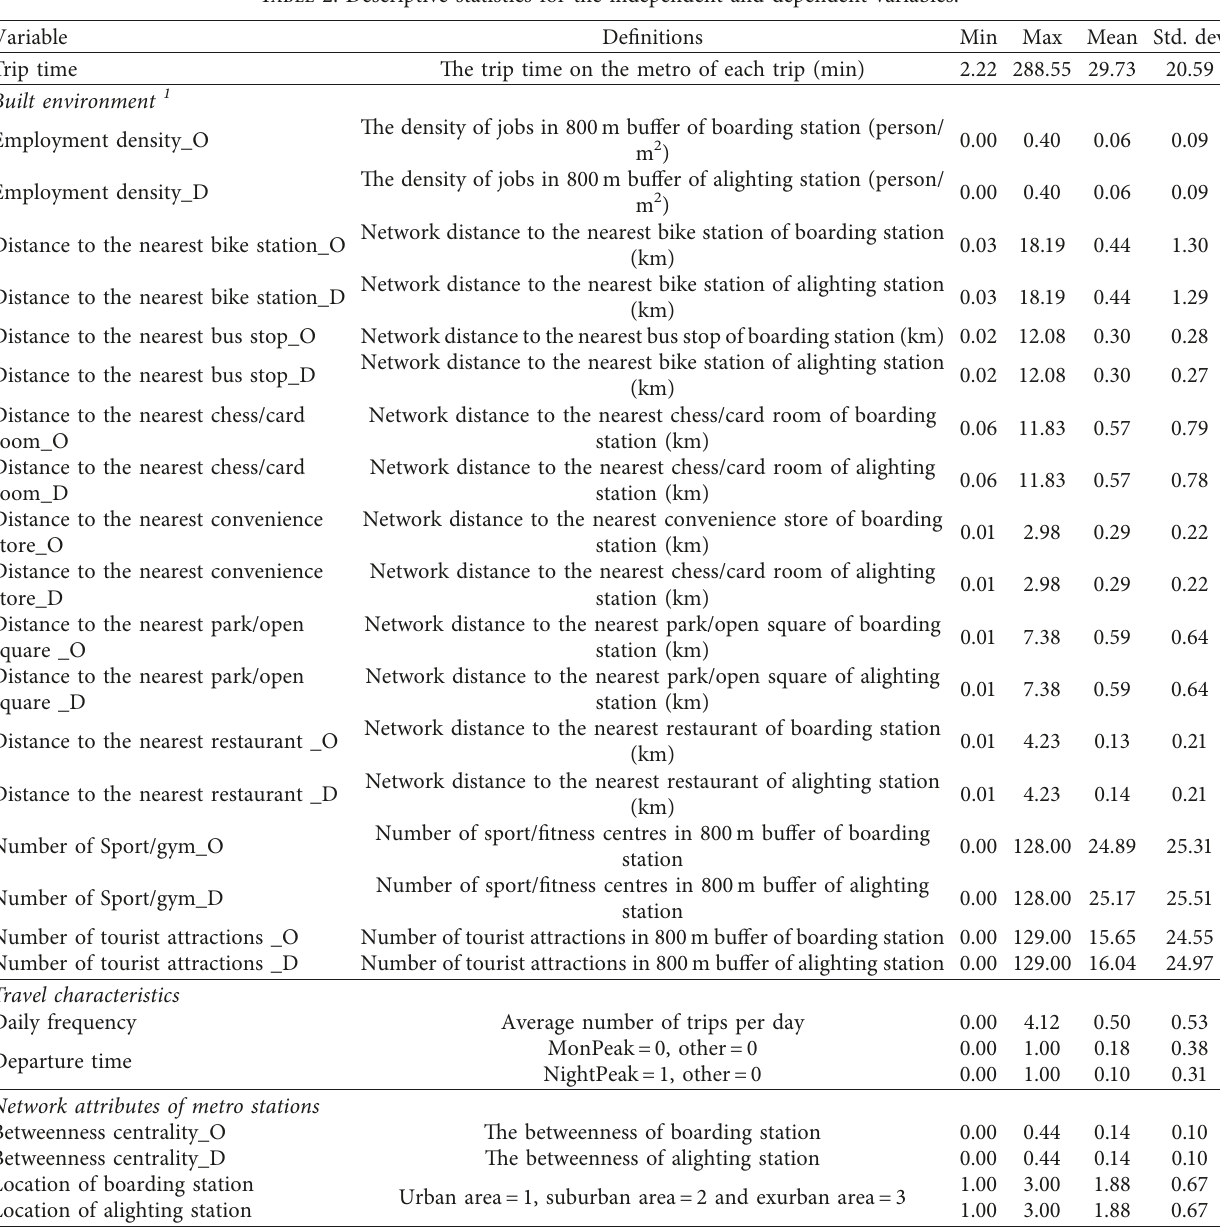
Table 2: Descriptive statistics for the independent and dependent variables.